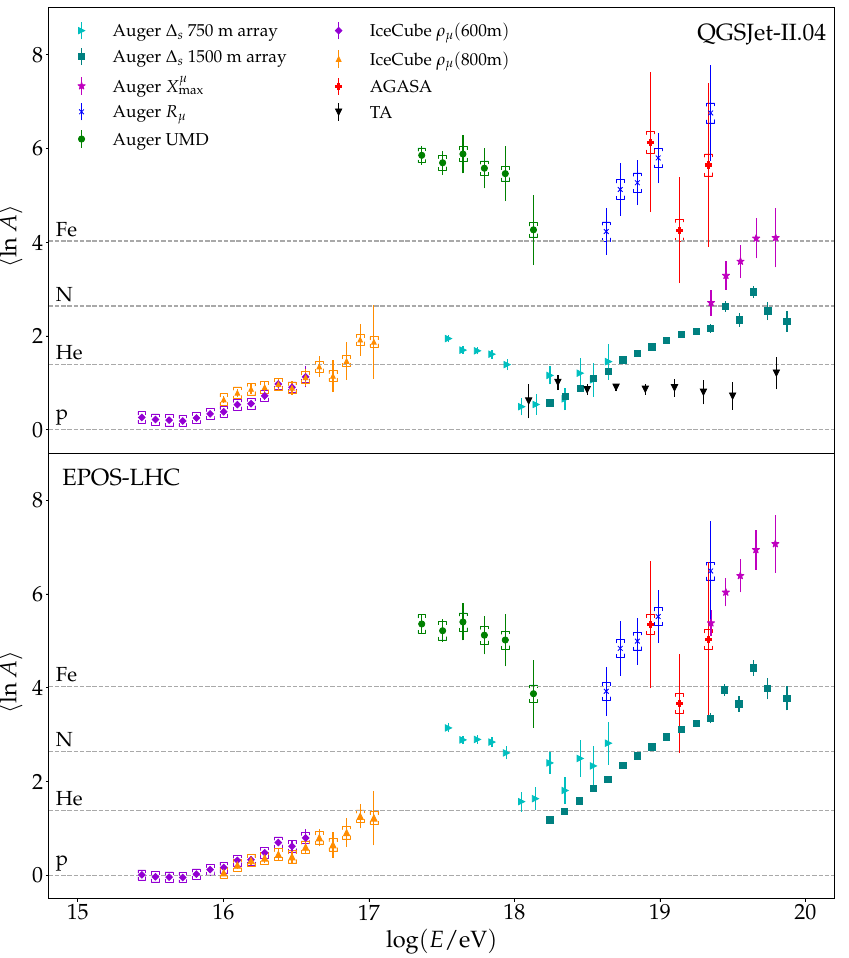
Figure 10. Mean value of ln A as a function of the logarithmic energy obtained from experimental data taken by the surface detectors of different experiments by using two different high-energy hadronic interaction models to interpret the data. The Auger data are labeled as: Auger ∆ s 750 m array [74], Auger ∆ s 1500 m array [74], Auger X µ max [75], Auger R µ [76], and Auger UMD [77]. The